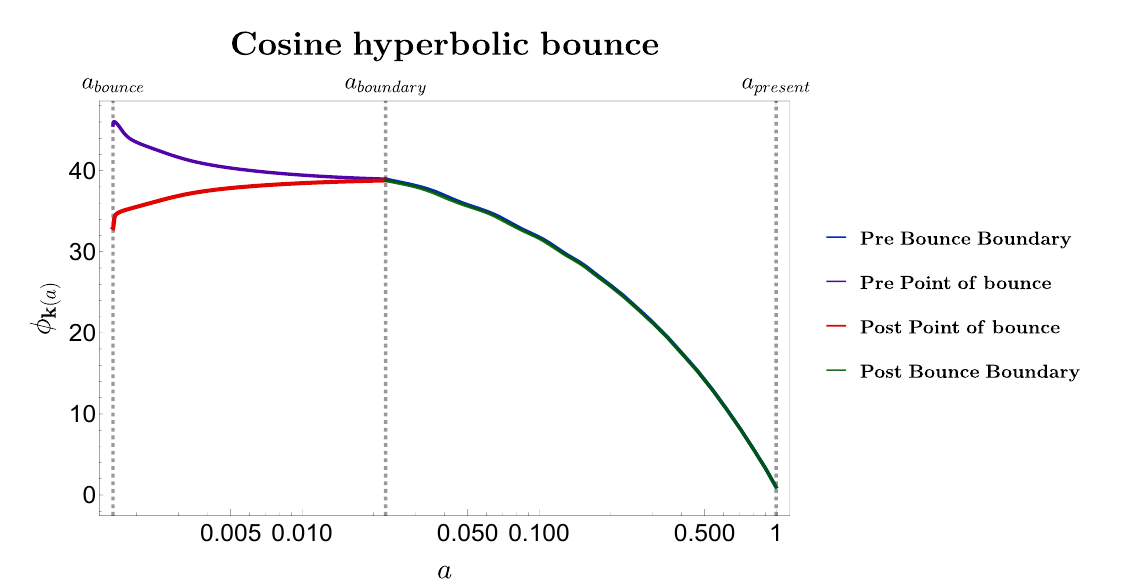
Figure 9: Squeezing parameter at different regions plotted against scale factor.